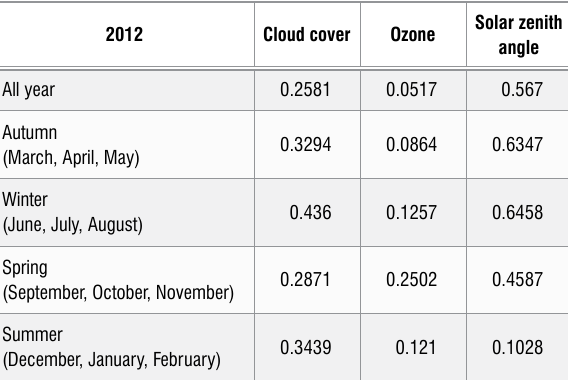
Winter (June, July,